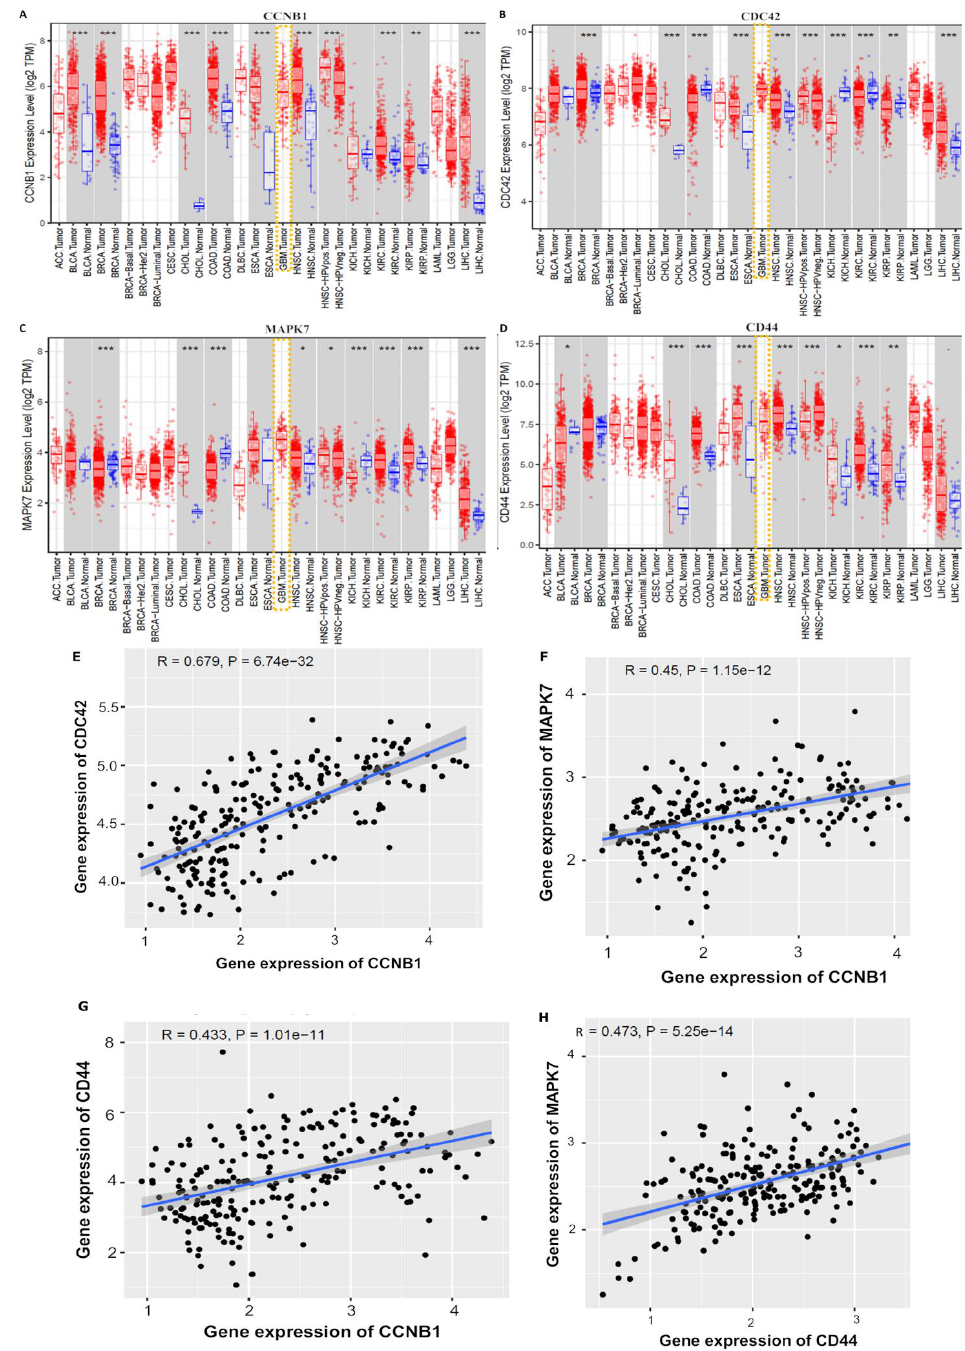
Figure 4. CCNB1/CDC42/MAPK7/CD44 oncogenic signatures are overexpressed in glioblastoma multiforme (GBM). ( A – D ) Increased mRNA levels of CCNB1/CDC42/MAPK7/CD44 in pan cancers, including GBM tumor tissues, compared to normal tissues from The Cancer Genome Atlas (TCGA). The relative gene expression level is indicated as transcripts per million (TPM), and expression values were normalized by log transformation of the statistical significance as evaluated by the Wilcoxon test, with p value significant codes: 0 ≤ *** < 0.001 ≤ ** < 0.01 ≤ * < 0.05 ≤ . < 0.1. ( E – H ) Correlation analysis of CCNB1/CDC42/MAPK7/CD44 oncogenes revealed correlations among all four genes when combined for analysis. Predicted results showed positive correlations ranging r = 0.43~0.67 of CCNB1 with CDC42, CCNB1 with MAPK7, CCNB1 with CD44, and MAPK7 with CD44 in GBM samples, with positive Pearson correlation coefficient and p < 0.05 considered statistically